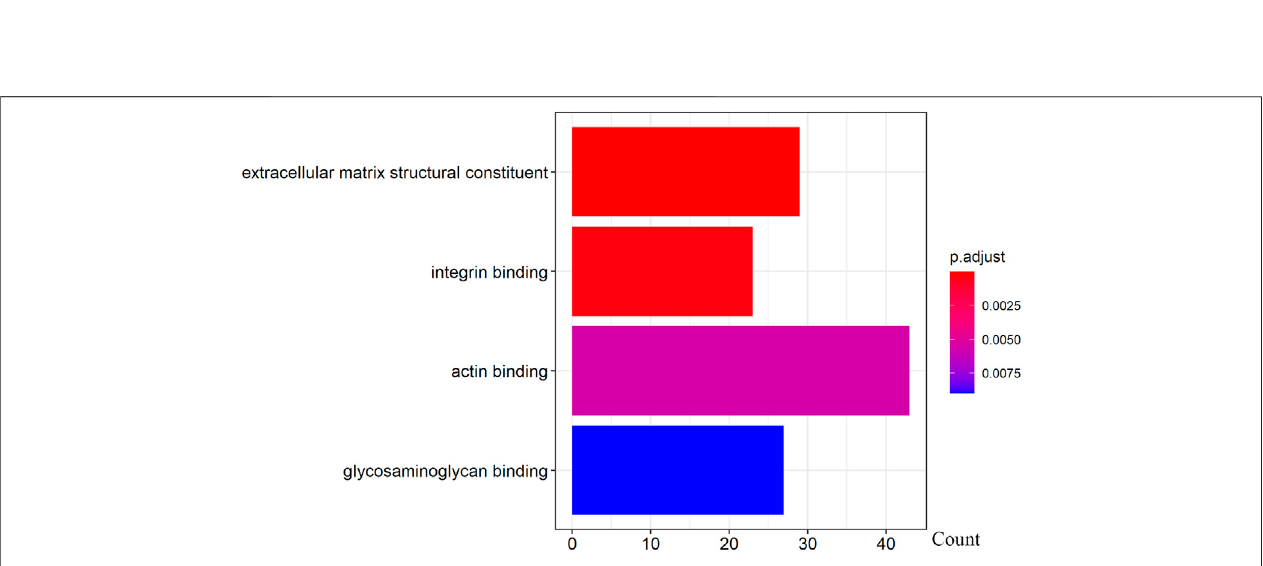
FIGURE 10 | GO analysis of WT1-AS target genes. Note: The target genes of lncRNAs were identi fi ed from Pearson ’ s correlation analysis (|correlation coef fi cient| > 0.4 and p < 0.001), GO analysis were performed in “ clusterPro fi ler ” and “ org.Hs.eg.db ” of R software to generated these functional pathways.